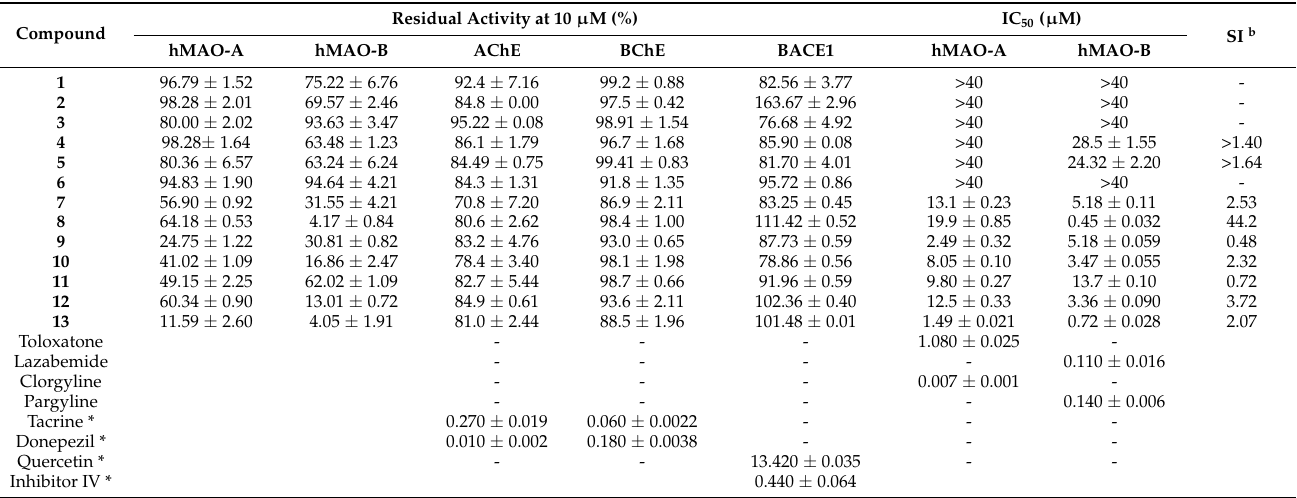
Table 2. Inhibitions of hMAO-A, hMAO-B, AChE, BChE, and BACE1 by the 13 compounds isolated from C. lineata pod extracts a